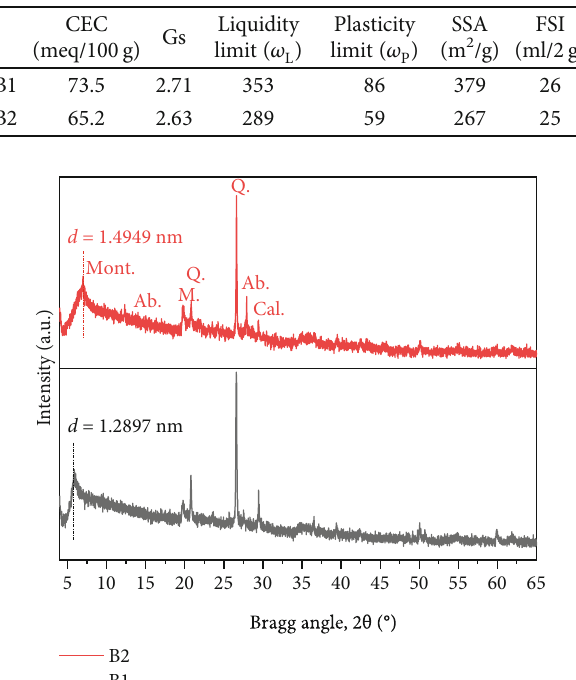
Table 2: Physical properties of tested bentonite.